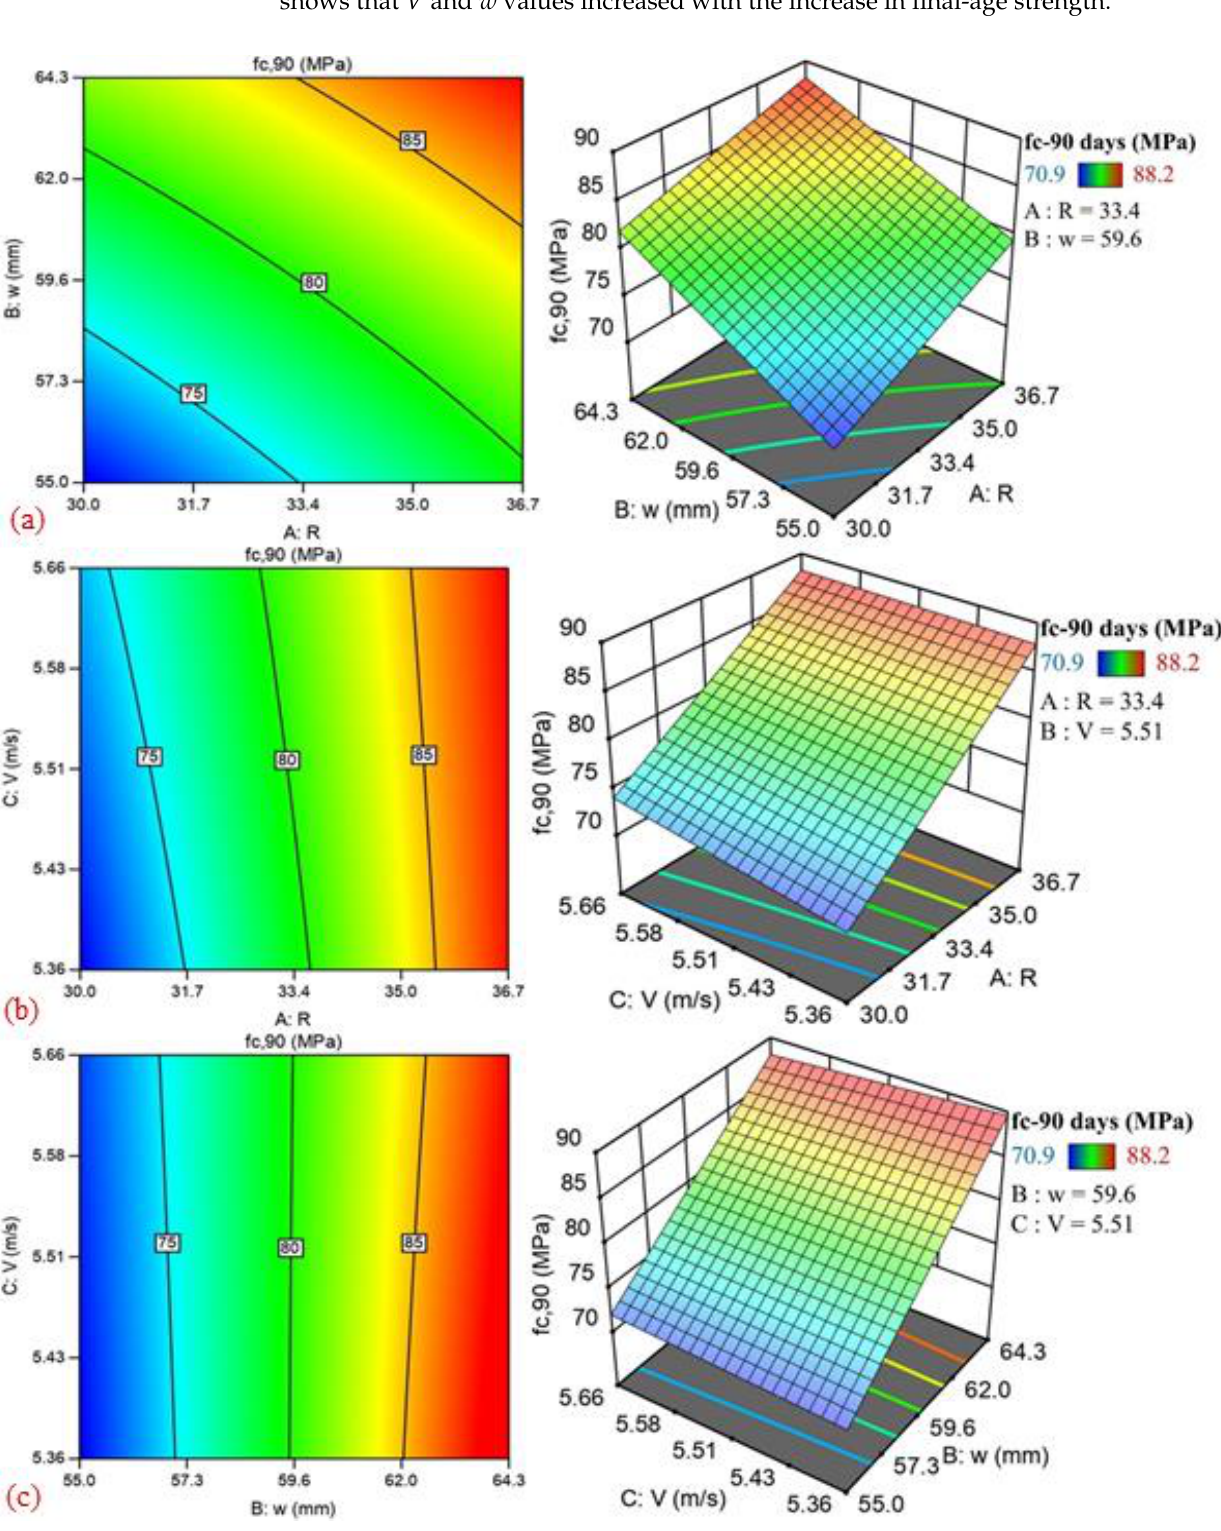
Figure 7. The effect of developed models on final-age strength: ( a ) Model 1, ( b ) Model 2, and ( c ) Model 3.